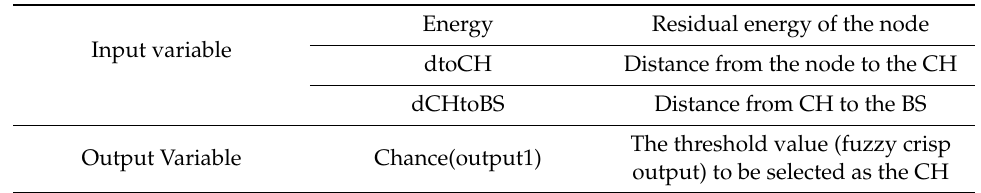
Table 3. FIS input and output variables during cluster formation.